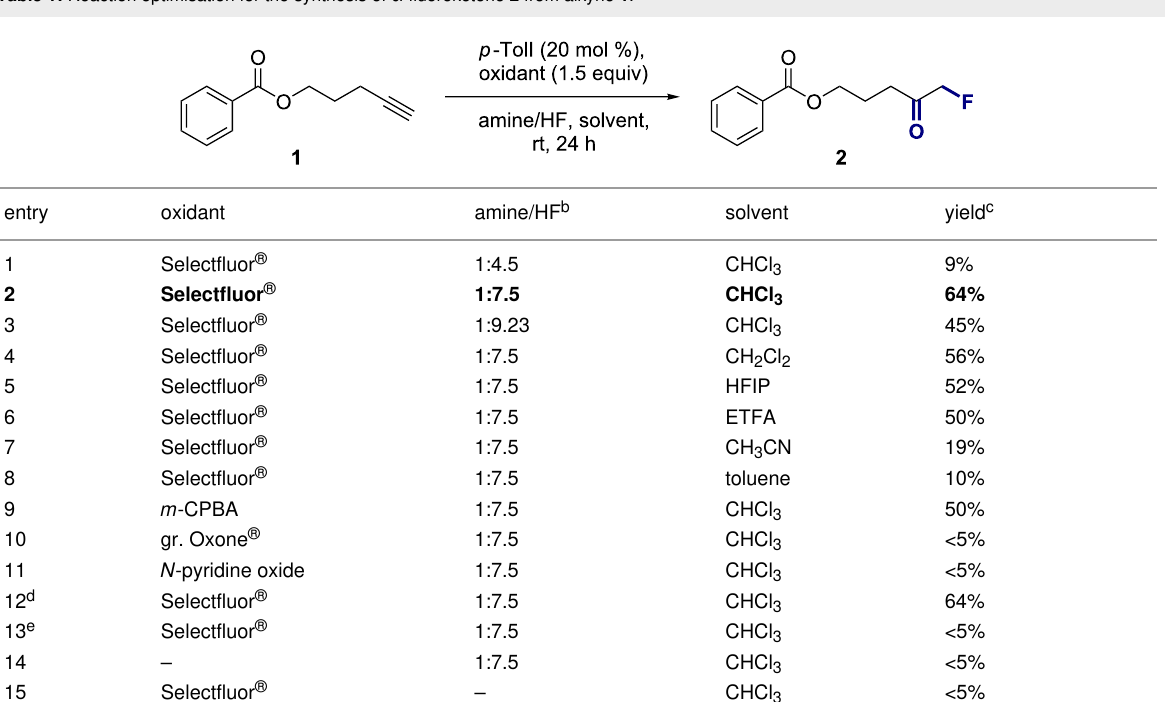
Table 1: Reaction optimisation for the synthesis of α -fluoroketone 2 from alkyne 1 .